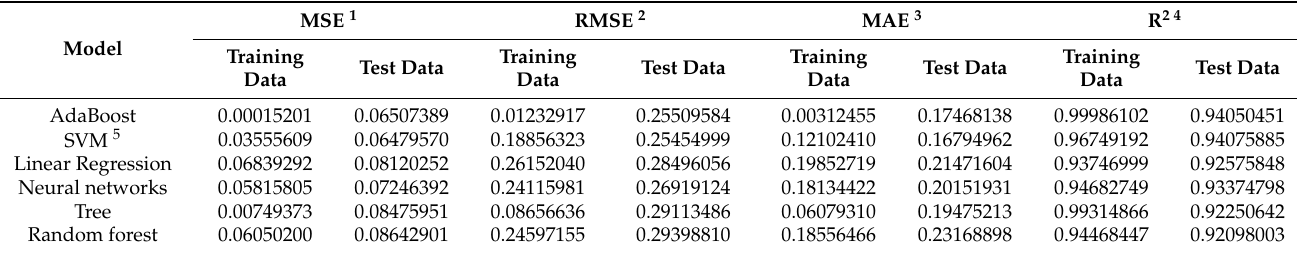
Table 2. Models tested during regression analysis.